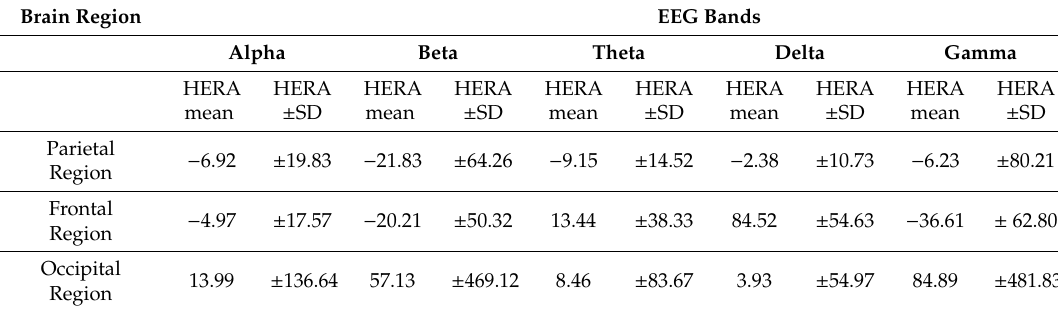
Table 2. Mean ± SD values for HERA model for an alpha, beta, theta, delta, and gamma-band for the frontal, parietal, and occipital regions.